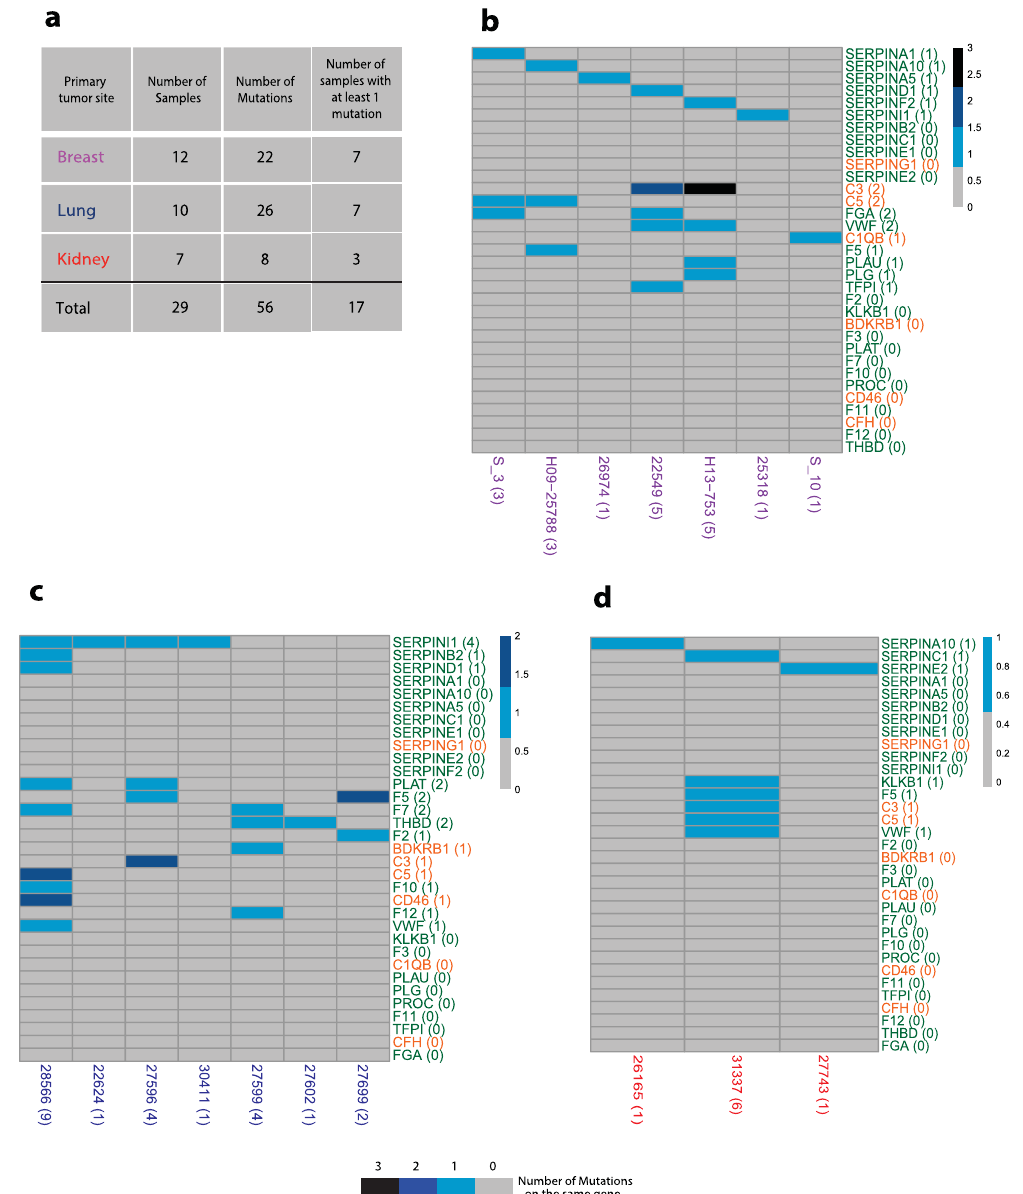
Figure 1. Distribution of somatic specific mutations. ( a ) Summary table of our 29 samples, including number of subjects per tumour type, total number of mutations found in coagulation and complement pathways, and number of unique genes mutated. ( b – d ) Oncoprint plots showing 33 genes belonging to the coagulation (26 genes, in green) and complement (7 genes, in orange) pathways on the rows and samples from three different primary tumours on the columns, ( b ) breast, ( c ) lung and ( d ) kidney respectively (17 out of 29 patients have at least one mutation on these pathways). Numbers in parenthesis represents the number of samples mutated on the specific gene (rows) and the number of mutated genes per sample (columns). Scales of blue indicates if a sample harbors one or more mutations on the same